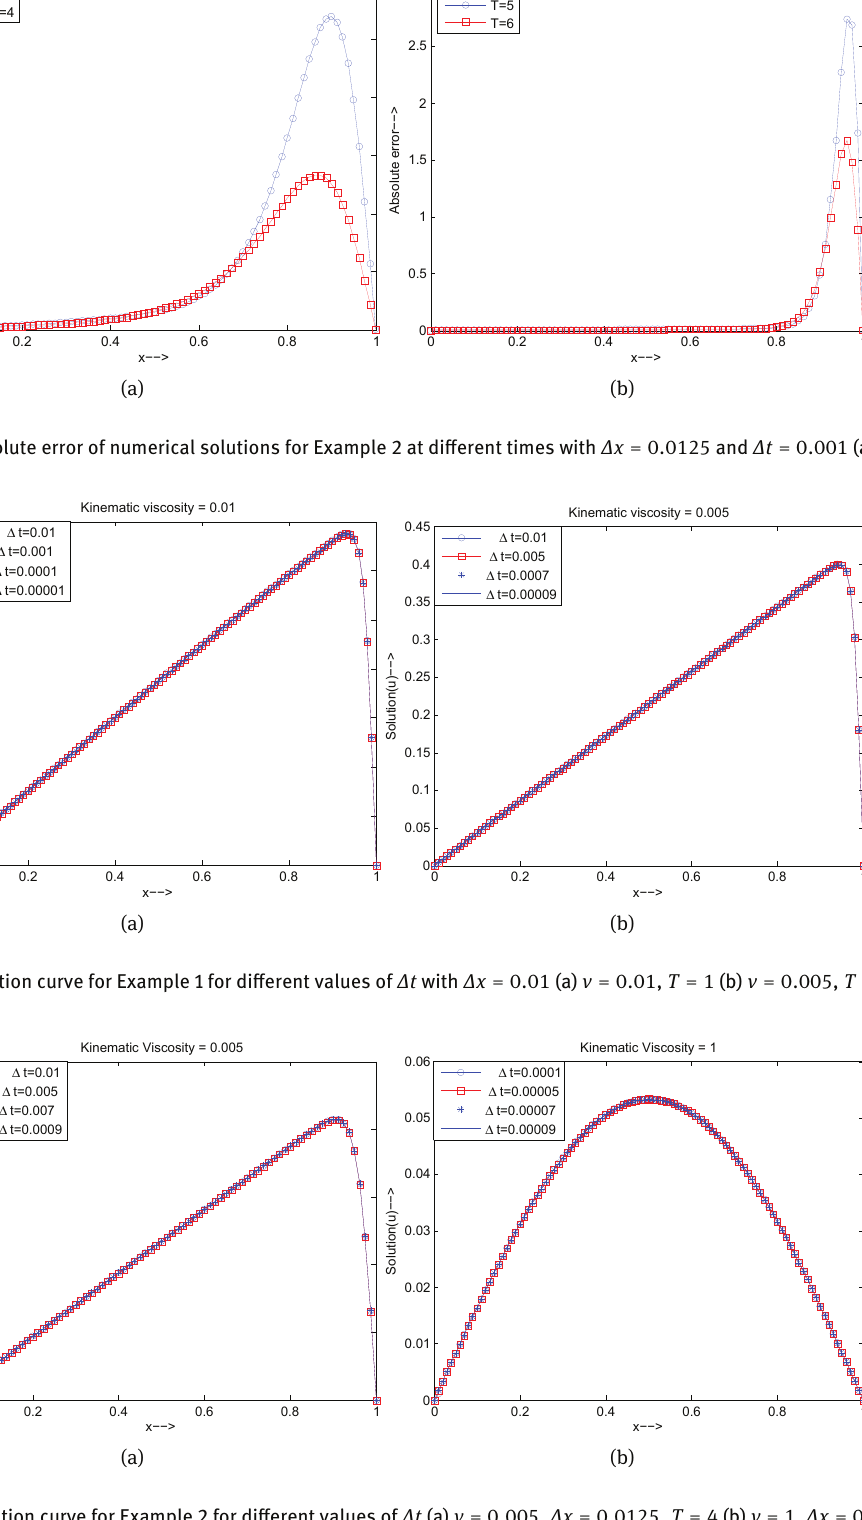
Fig. 20: Solution curve for Example 2 for different values of Δt (a) ν = 0.005 , Δx = 0.0125 , T = 4 (b) ν = 1 , Δx = 0.01 , T = 0.3